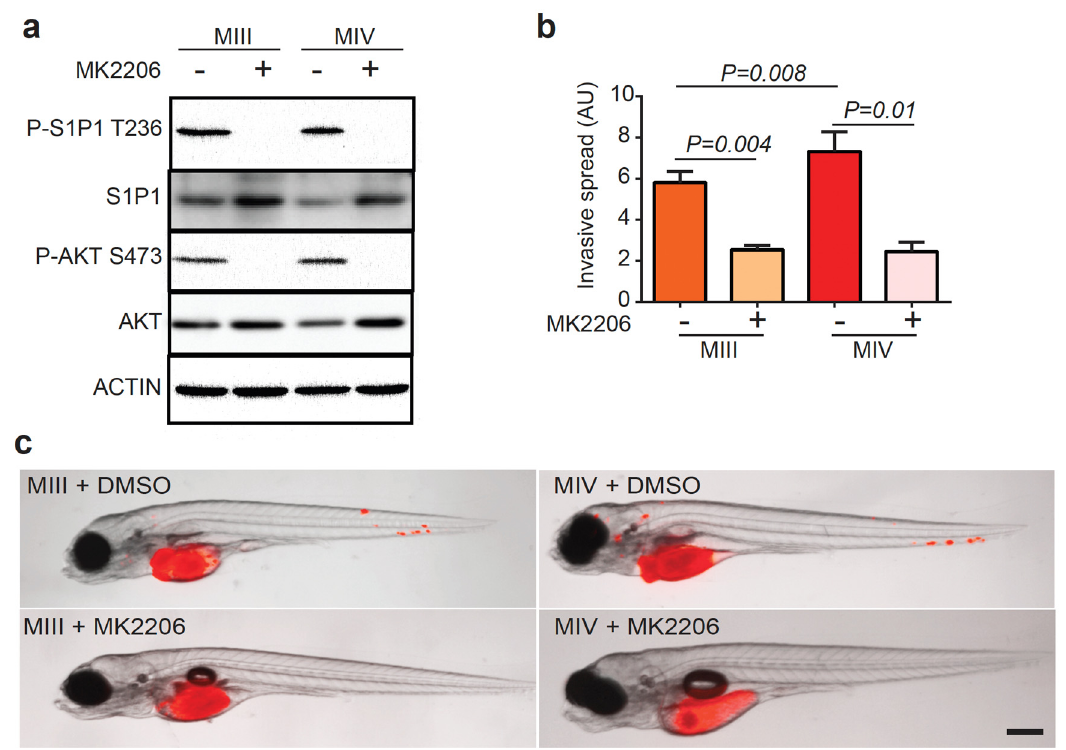
(Figure S4a), MK2206 significantly suppressed the distant spread of MIII and MIV cells at three dpt, compared to vehicle-treated control cells (Figure 4b,c).